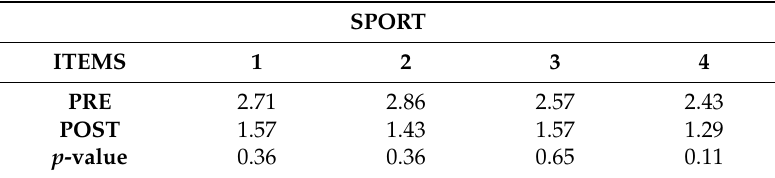
Table 4. DASH work and DASH sport score.